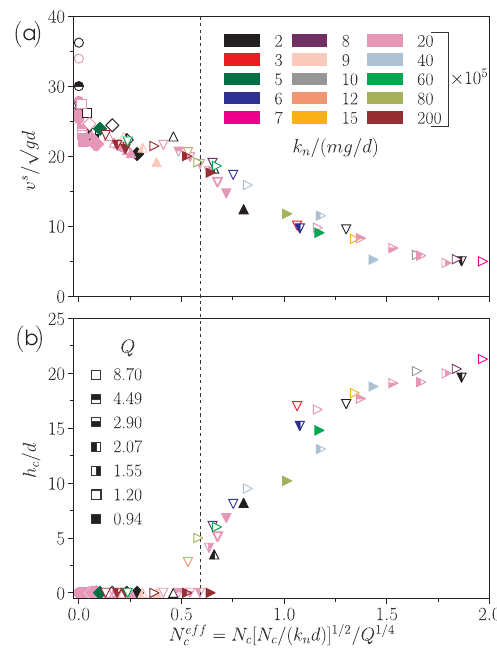
Figure 2. (a) Free surface velocity v s and (b) thickness h c of the plug region as a function of the e ff ective adhesion force (eq.1) for di ff erent values of the adhesion N c , sti ff ness k n and quality factor Q , showing the collapse of all the